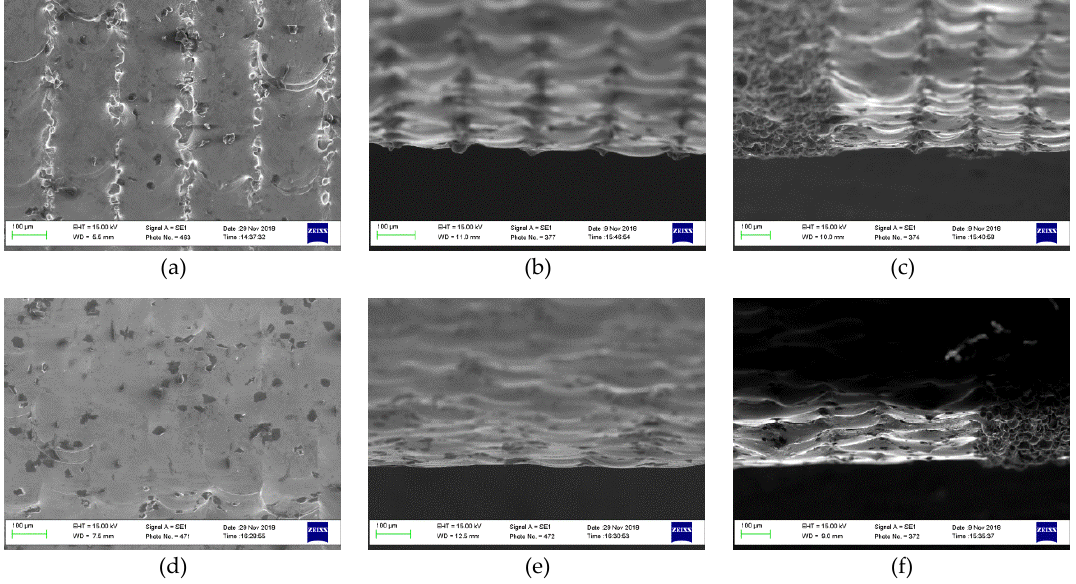
Figure 7. SEM micrograph showing the top and side views of AM 316L SST samples polished with 50 rpm, 0% overlap, one scanning pass, and 90 W in ( a ) top, ( b ), and ( c ) side-view, as well as 130 W in ( d ) top, ( e ), and ( f ) side view.